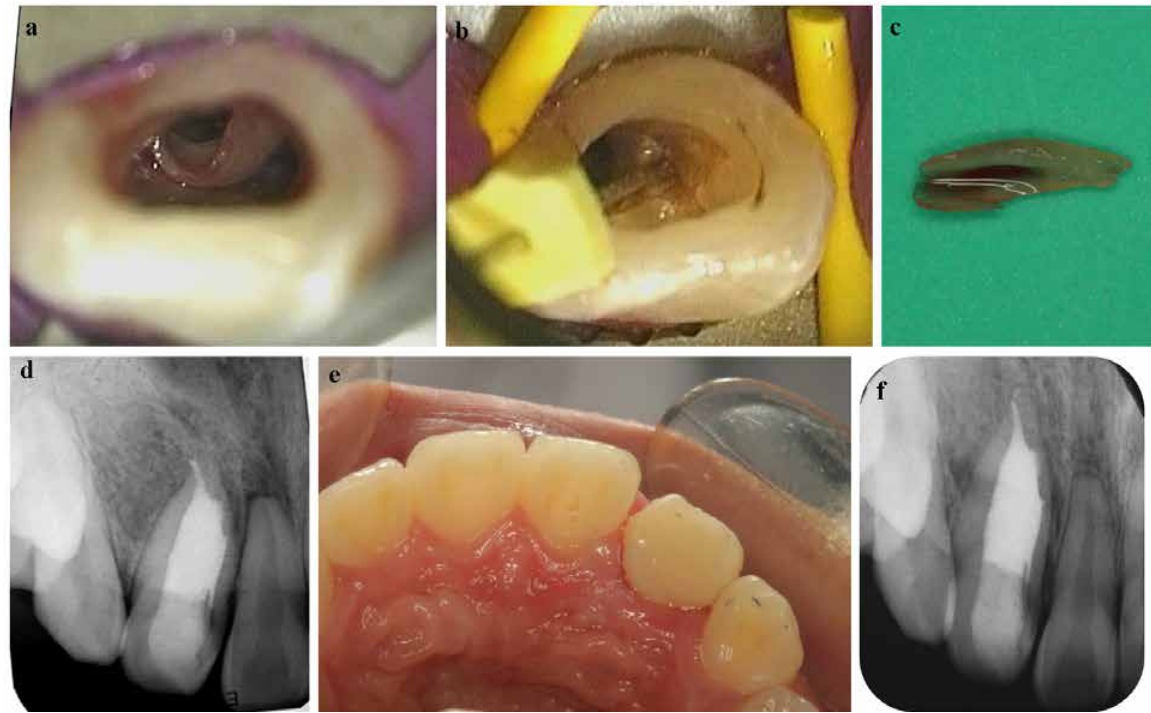
Figure 2: (a) The invaginated structure easily viewed under the DOM after troughing with the ultrasonic tip. (b) H-file used to engage the invaginated structure to remove it from the canal. (c) The removed invaginated structure. (d) IOPA taken after the obturation showing the completely filled canal. (e) Postoperative clinical view of the lingual surface after the restoration. (f) Two- year follow-up IOPA showing the healed